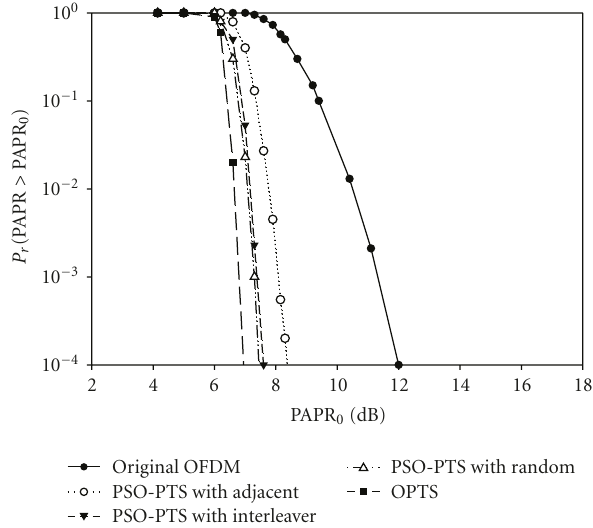
Figure 5: CCDF comparisons of OFDM signal among di ff erent subblock partition